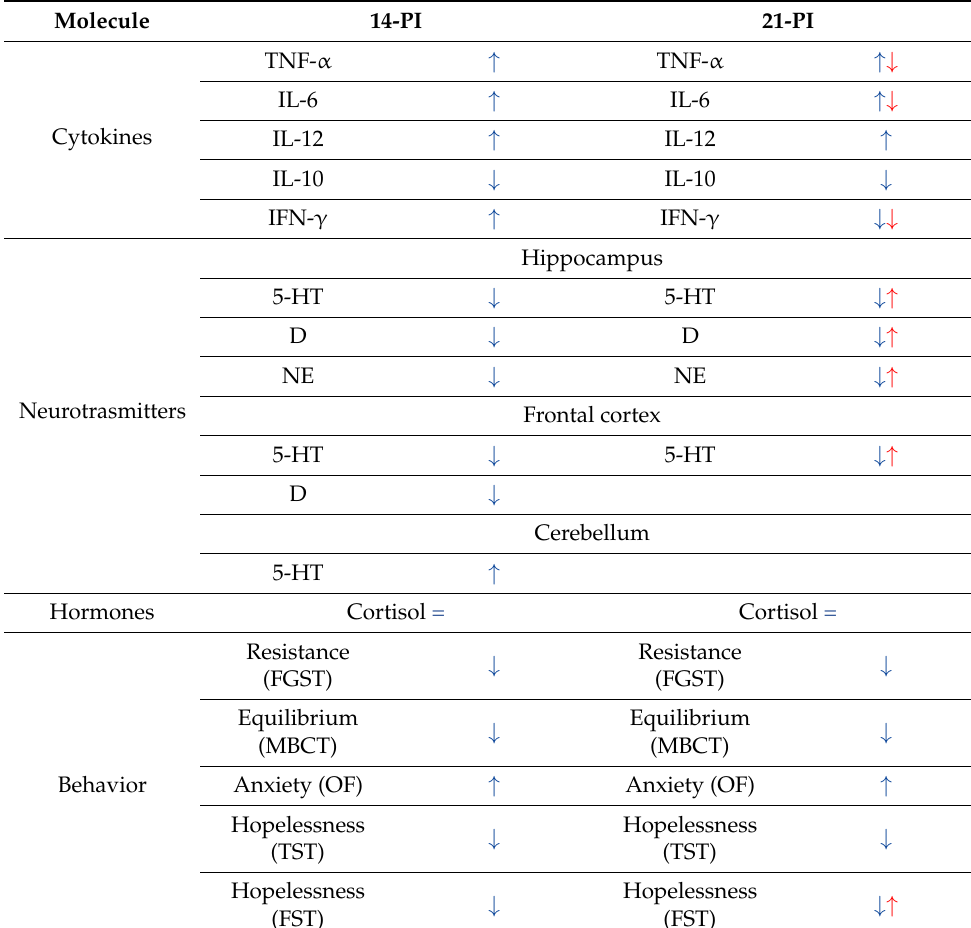
Blue arrows indicate comparison with control group; red arrows indicate comparison with 14-PI mice group; PI, post-infection; =, indicate no changes in comparison with control group; FST, forced swimming test; MBCT, motor balance and coordination test; FGST, forelimb grip strength test; OF, open field test; TST, tail suspension